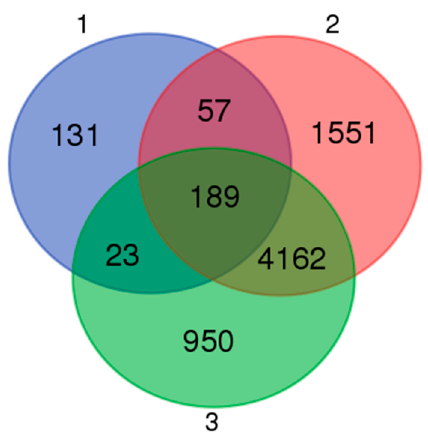
Figure 6. Venn diagram of the unigenes distributed in three groups. Group 1: DEGs between Guanzhong and Chakouyi horses; group 2: DEGs between DTs and UDTs of cryptorchids; group 3: DEGs between DTs of normal horses and UDTs of cryptorchids.